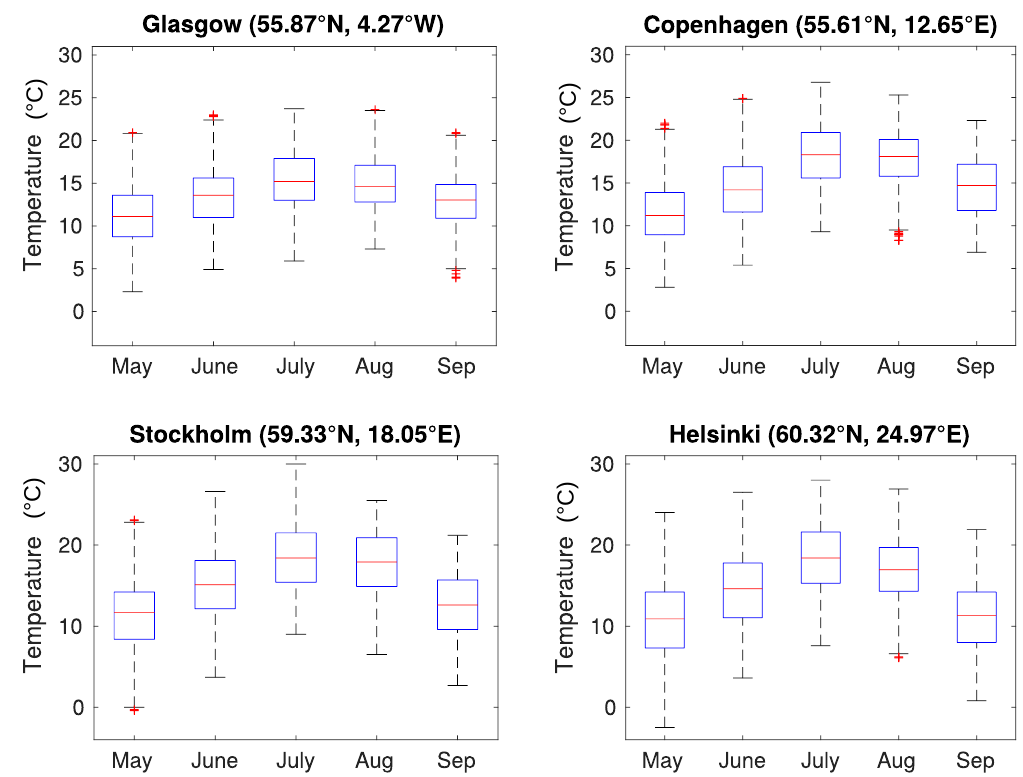
Figure 4. Outdoor air temperatures in the cities located above the 55th